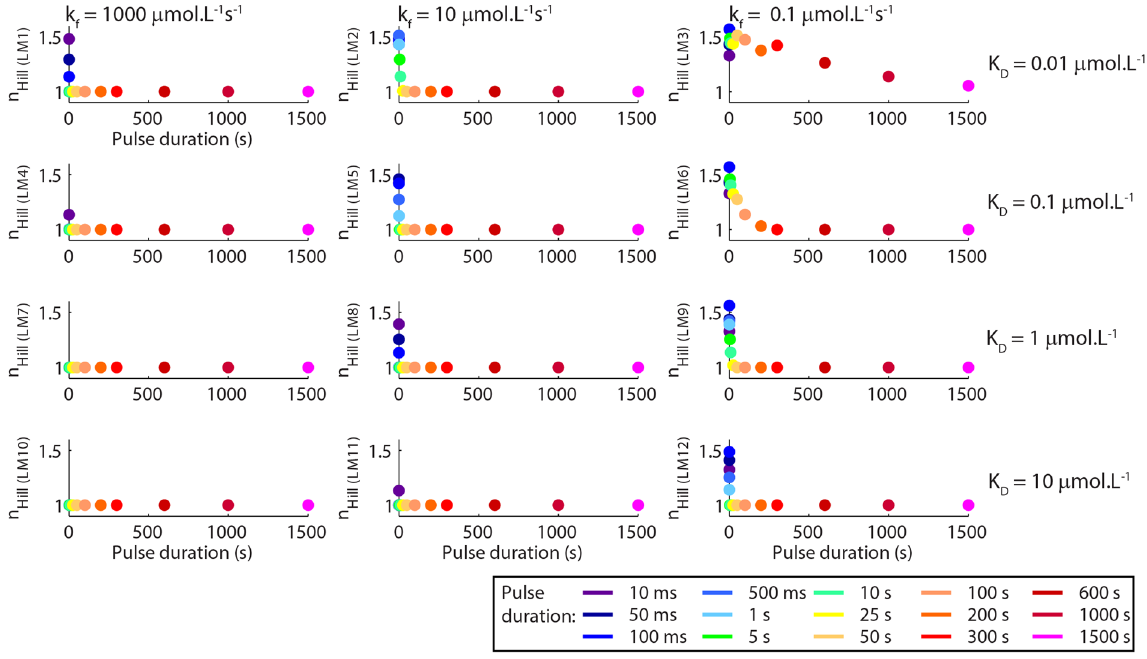
Figure 4. Values of n Hill estimated from the dose-response curves showed in Fig.